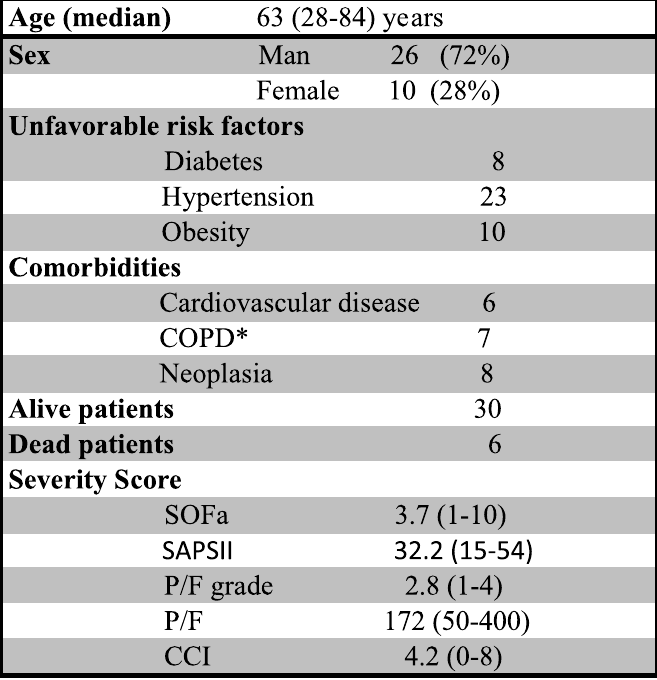
COPD chronic obstructive pulmonary